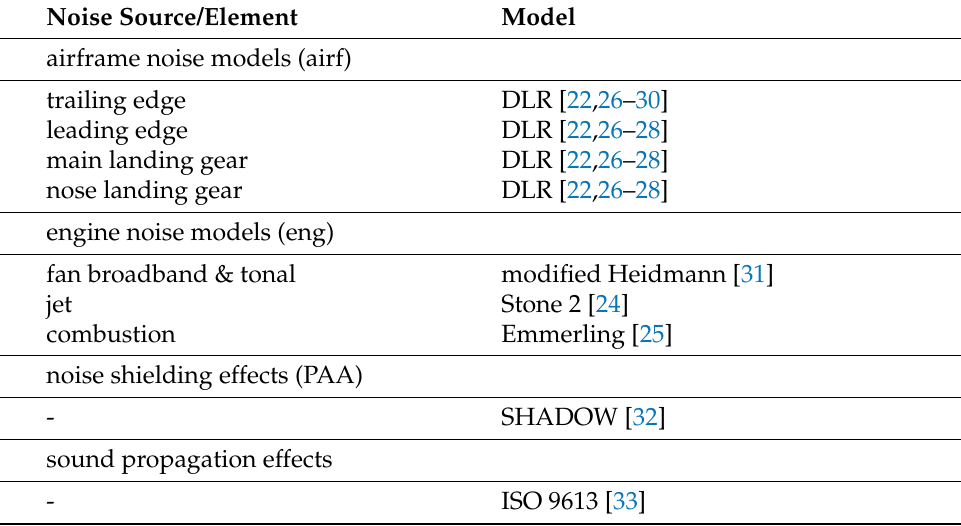
Table 1. PANAM system noise assessment: source models selected for this